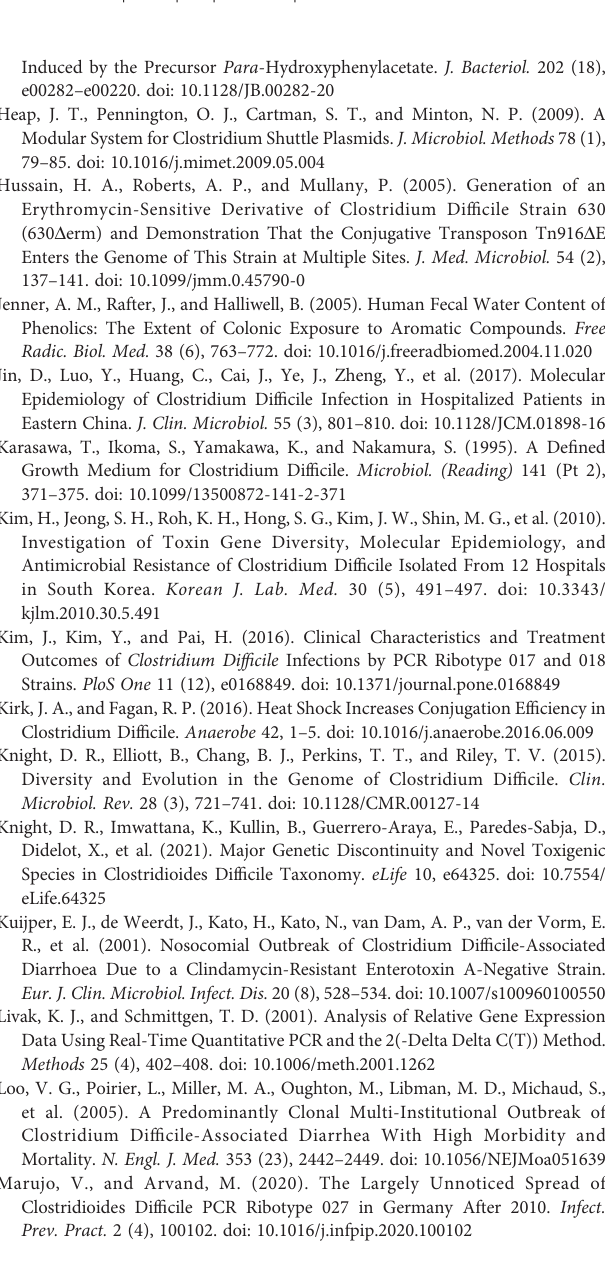
Supplementary Figure S4 | Growth of C. dif fi cile in acidic BHIS media. 630 D erm (black bars) and 630 D erm hpdC ::CT (gray bars) strains were grown in BHIS alongsideBHIS,withthepHloweredto6.6,6.2,5.8,and5.4tomatchthepHfound at 1, 2, 3, and 4 mg/ml p -HPA, respectively, with the fi nal pH measured after 24 h of growth. Regression analysis was used to determine whether there were any signi fi cant differences in the fi nal pH between the two strains at each starting pH. Error bars represent standard deviation, and data represents the minimum of three independent replicates. ns, non-signi fi cant.